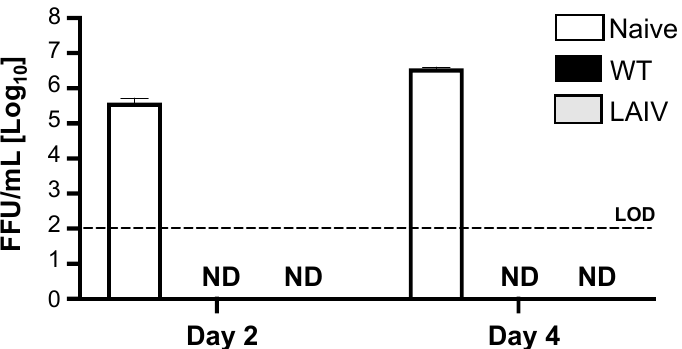
Figure 6. Protective efficacy of B/Brisbane/60/2008 MDV LAIV: C57BL/6J 6-weeks old female mice ( n = 6) were infected intranasally with 10 6 FFU of either B/Brisbane/60/2008 WT (black) or MDV LAIV (gray), or mock vaccinated (white). On day 28 post-infection, mice were challenged with 10 6 FFU of B/Brisbane/60/2008 WT. At days 2 ( n = 3) and day 4 ( n = 3) post-challenge, mice lungs were collected and viral titers were determined by immunofocus assay (FFU/mL). Dotted line indicates the LOD of the assay (200 FFU/mL). ND= Not detected.